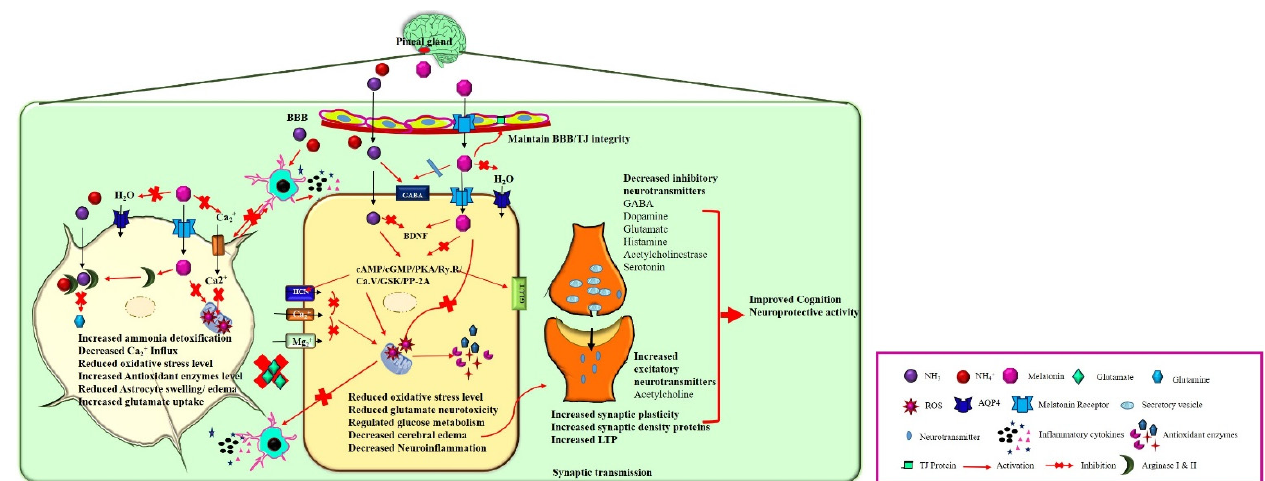
Figure 2. Neuroprotective action of melatonin on HE brain . In the brain, melatonin is synthesized and released from pinealocytes of the pineal gland. Melatonin binds to its receptors and activates various physiological functions such as 1. In astrocytes: Melatonin detoxifies the excess ammonia by activating the Arginase I and II enzyme that prevents glutamine synthesis and glutamate accu- mulation in extracellular fluid. Furthermore, melatonin prevents neuroinflammation and astrocyte swelling by decreasing the Ca 2+ influx and inhibiting water channel activation. 2. In a neuron, mel- atonin inhibits the cAMP/cGMP/PKA/Ry.R/Ca.V/GSK/PP-2A signaling pathway leading to the de- creased oxidative stress level, inhibits the microglial activation, and reduces the inhibitory neuro- transmitter synthesis and release. Moreover, melatonin regulates glucose metabolism by acting on insulin/GLUT receptors, facilitating synaptic plasticity, LTP, cognition by increasing the synaptic density proteins expression, and increasing the excitatory neurotransmitter release. 3. Hepatic Encephalopathy (HE) and Melatonin (Hyperammonemia) The neuropathogenesis of HE remains unclear. The complications of HE include glu- tamine, chronic infections, and profuse gastrointestinal bleeding, and causes elevated am- monia levels in the blood and CNS [9]. According to the prevailing hypothesis of HE, gut- derived nitrogenous toxins of ammonia can cross the BBB and induce neurological symp- toms [2]. The biochemical analysis in numerous clinical and experimental studies has con- firmed increased circulatory ammonia levels in HE [13]. HE experimental models can also be created by increasing the ammonia level in blood circulation [39,40]. In this review, ammonia is defined as the concentration of both ammonia (NH 3 ) and ammonium ion (NH 4+ ). NH 3 is a lipophilic compound that can cross the plasma mem- brane, while NH 4+ is transported through ionic channels [41]. Ammonia is derived from all amino acids, nucleic acids, and renal glutamine. Ammonia is also produced by normal floral bacterial enzymes within the gastrointestinal tract (3–4 mg/day) [41] and is metabo- lized by bacterial enzymes in the gastrointestinal tract and in the liver via the urea cycle. A high level of ammonia crosses the BBB, which leads to oxidative stress, alters glucose and neurotransmitter metabolism, and disrupts of neuronal functions and structure, such as astrocyte swelling in HE [42]. Based on different studies, melatonin is a potent hepato-neuroprotector against hy- perammonemia (Table 1). The liver is the principle organ involved in nitrogen homeosta- sis. Hepatic disease leads to impaired urea cycle, ammonia trafficking, and hyperammo- nemia [43]. In the urea cycle, ammonia is detoxified by five enzymes (arginase, arginino- succinate synthetase, argininosuccinate lyase, carbamyl phosphate synthetase I (CPS-I), and ornithine carbamyl transferase) [44]. Arginase is the final process enzyme that con- verts L-arginine to l-ornithine/urea to degrade the nitrogenous toxin of ammonia [45]. There are two types of arginase in mammals: 1. cytosolic arginase I, which is expressed in the liver (>98%); and 2. mitochondrial arginase II, which located in extrahepatic tissues (2%) (renal, brain, lung, intestine, and breast) [45]. According to Aydogdu et al., melatonin